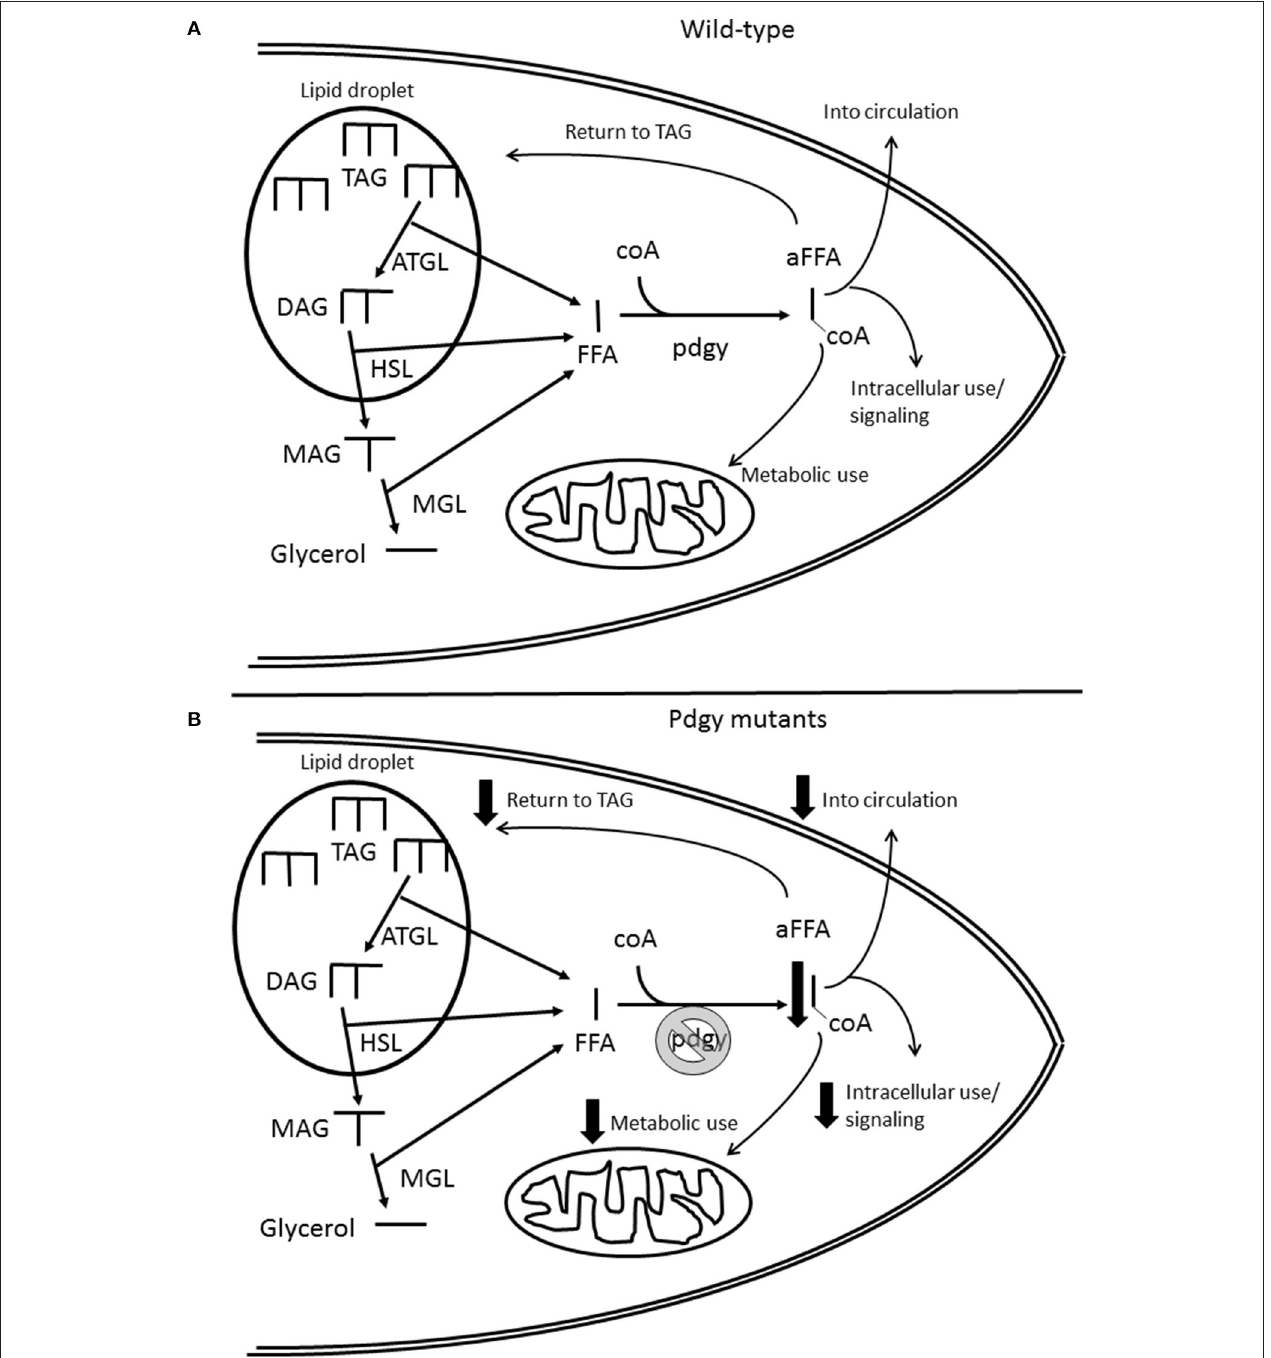
FIGURE 9 | Schematic of the role of pdgy in cellular lipid metabolism. (A) Under normal conditions, the adipose triglyceride lipase (ATGL) releases free fatty acids (FFA) and diacylglycerides (DAG) from the lipid droplet. Another FFA is released from DAG by hormone sensitive lipase (HSL) and another FFA is released from the Monacylglyceride (MAG) by monoglyceride lipase (MGL) leaving glycerol. Pdgy then adds a coA molecule to the FFA to activate it (aFFA). The aFFA then is used for metabolic, may be reinserted into the lipid droplet, cell signaling or protein post-translational modifications, or distribution to other tissues through the circulation. (B) The absence or reduction of pdgy would result in less FFA coverted to aFFA. This mutation would potentially reduce the FFA available to carry out necessary functions within the cell and throughout the organism. Another consequence may be the increase in the levels of FFA within the cell.